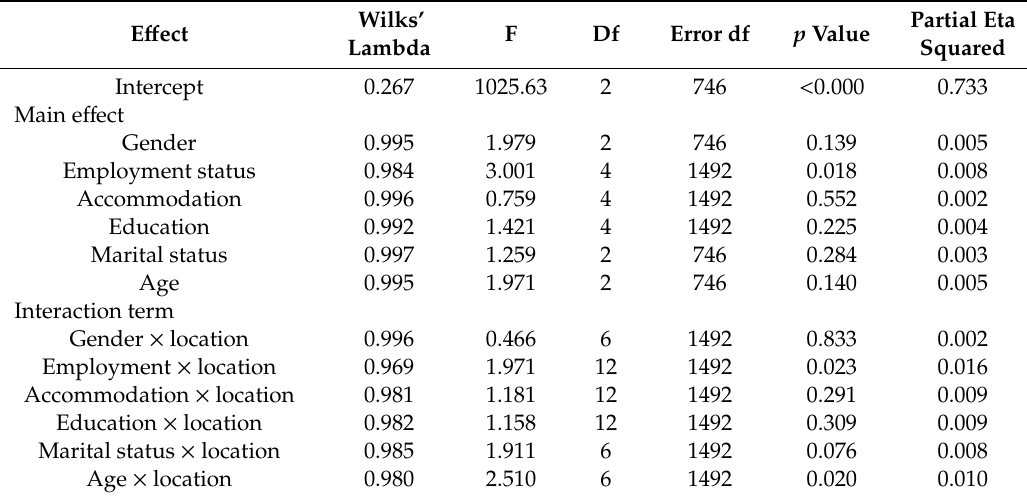
Table 2. Associations between demographic factors and dementia literacy using multivariate analysis of variance